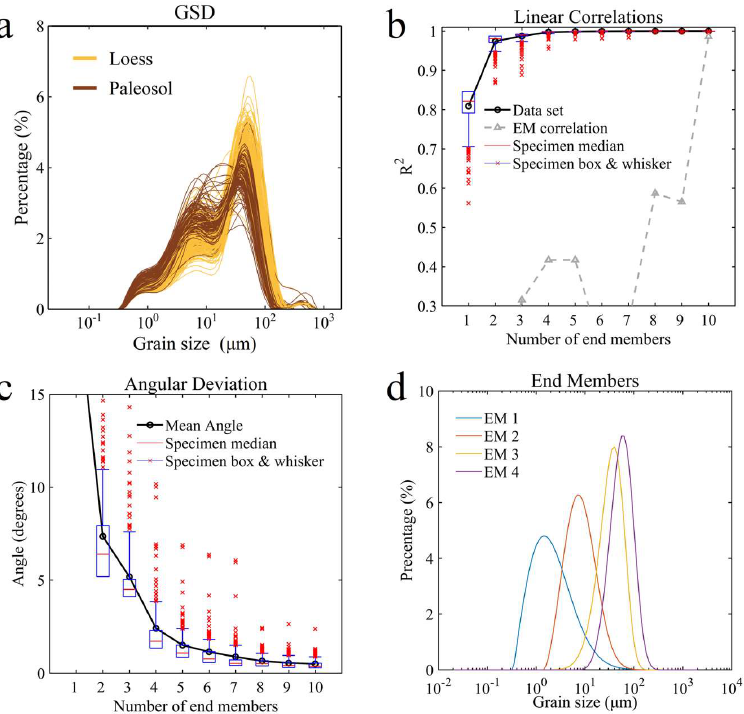
Figure 2. ( a ) Grain-size distribution (GSD) diagrams of all samples, ( b ) linear correlations, ( c ) angular deviations, and ( d ) endmember distributions.